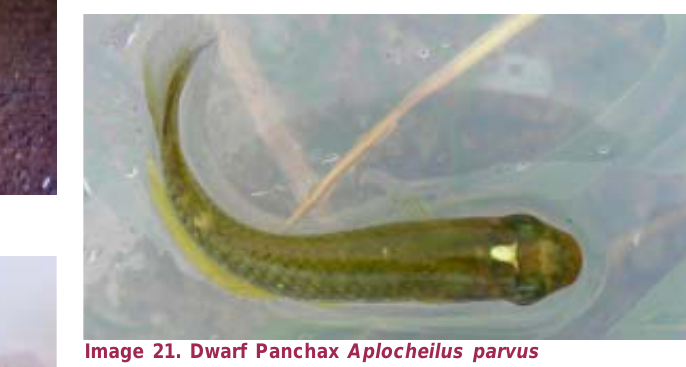
Image 21. Dwarf Panchax Aplocheilus parvus